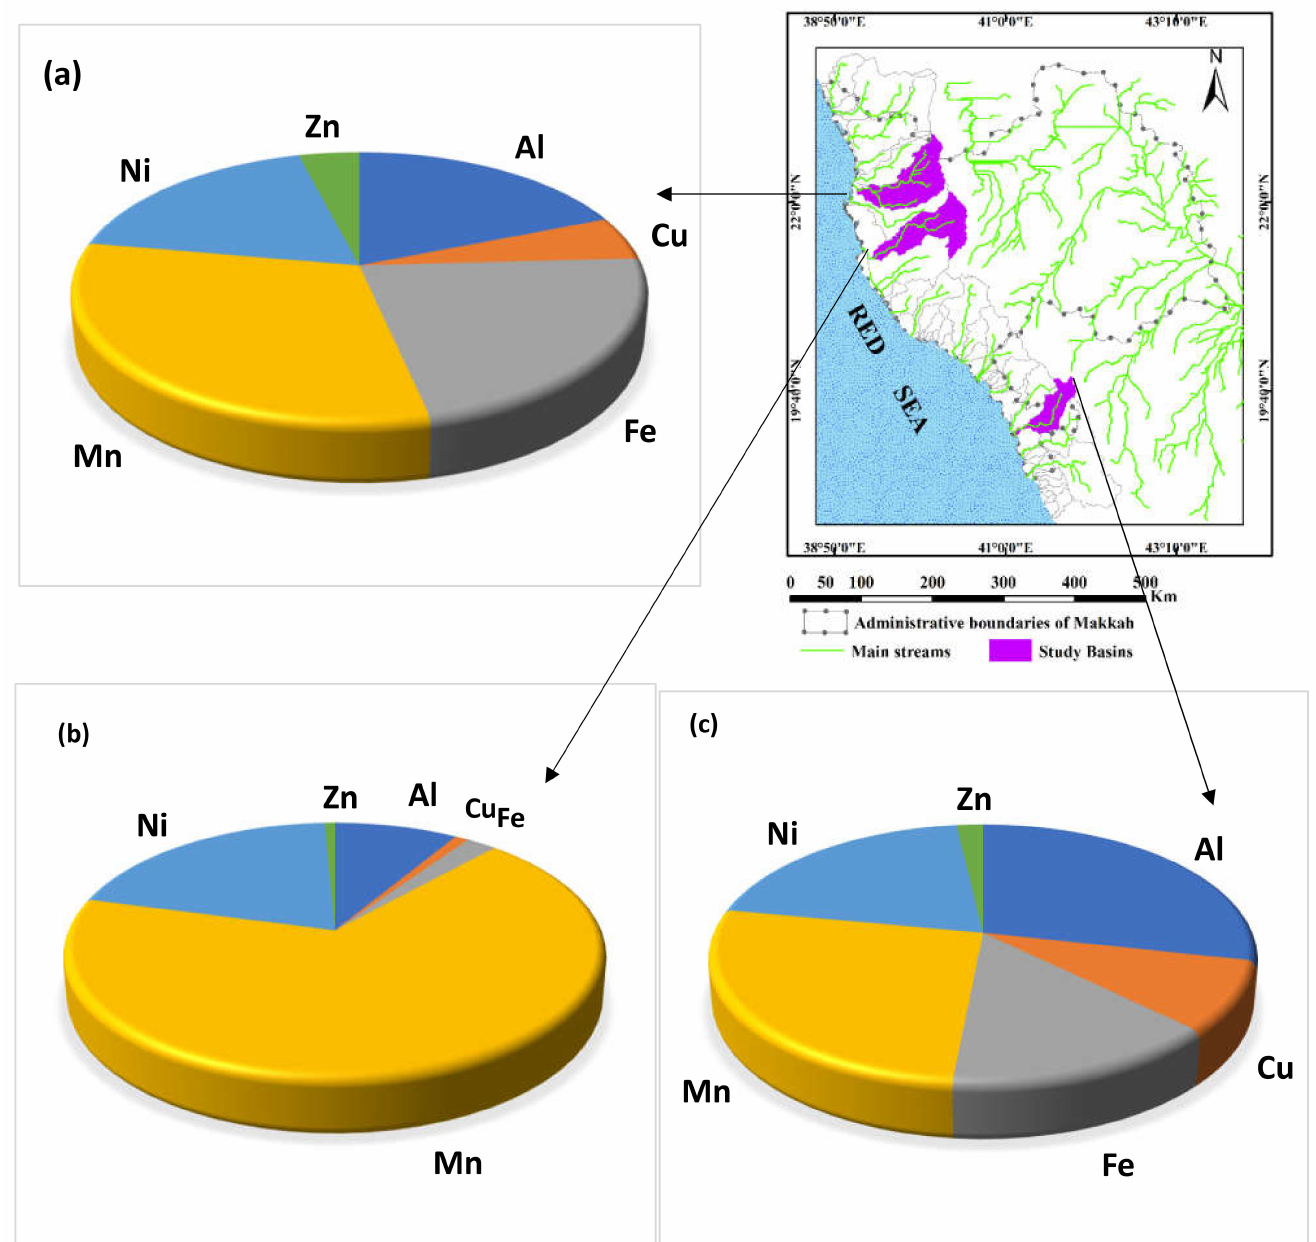
Figure 11. Three-dimensional pie showing the relative pollution index of metals for selected wadies: ( a ) Wadi Marawani, ( b ) Wadi Fatimah, and ( c ) Wadi Qanunah, Makkah Al-Mukarramah